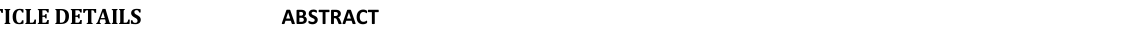
Samples were taken at the start (inlet) and end (outlet) of selected portion to evaluate the amount of arsenic leached through that portion. At inlet portion, nine samples were taken from corners and center at three different depths and mix together to get one representing sample of